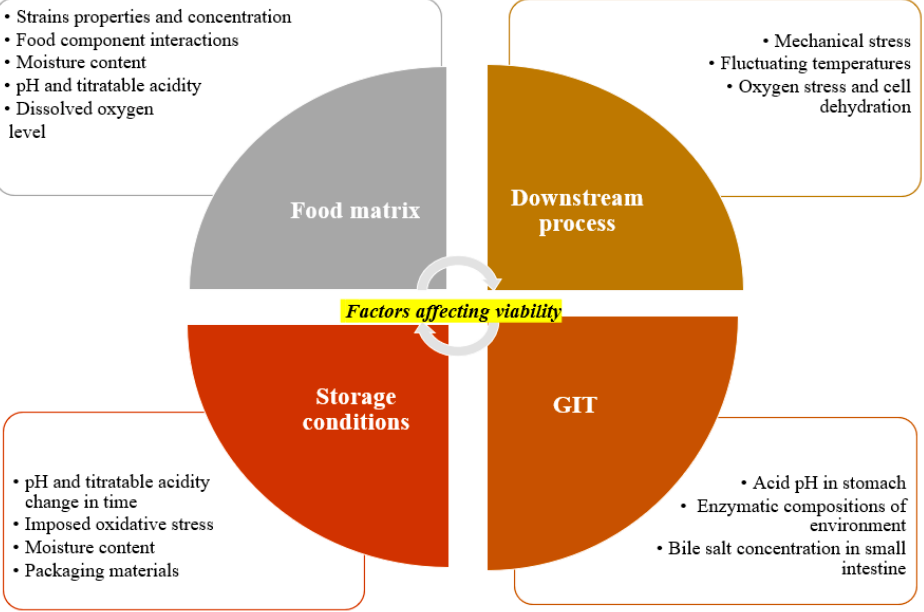
Figure 2. Factors influencing viability of probiotics [62].